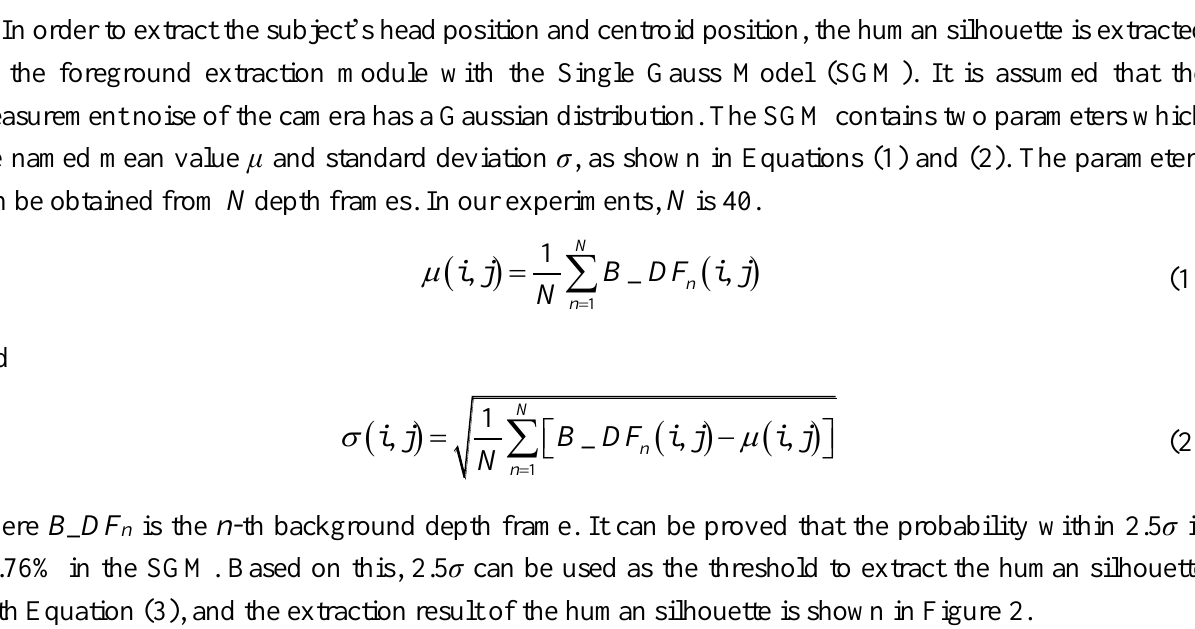
Figure 1. Flow chart of the proposed fall detection